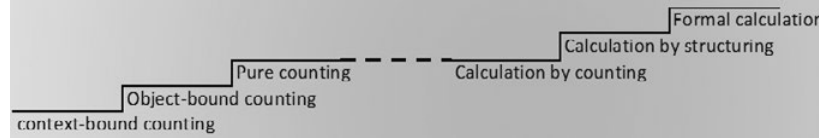
Figure 1: TAL Domain levels for calculating